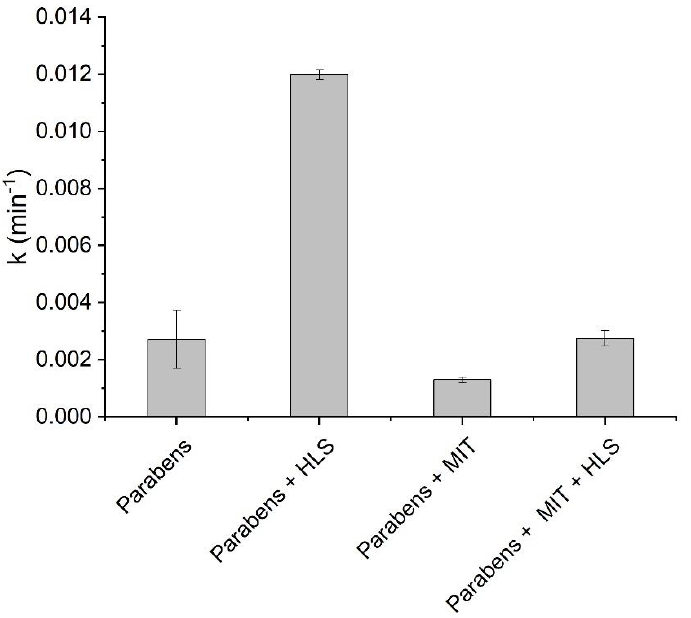
Figure 5. Effect of MIT on the degradation kinetics of parabens, in the presence and absence of HLS. [MIT] = 5 mg·L −1 , [parabens] = 5 mg·L −1 each, [H 2 O 2 ] = 31.8 mg·L −1 (stoichiometric), [Fe (III)] = 5 mg·L −1 , [HLS Coffee] = 25 mg·L −1 .